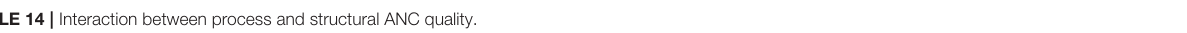
* The comparison groups: primary-level education or less, other health workers (outside doctors, registered nurses, or midwives), other health facilities (other than national, provincial, or district-level hospitals), and rural facility locations.